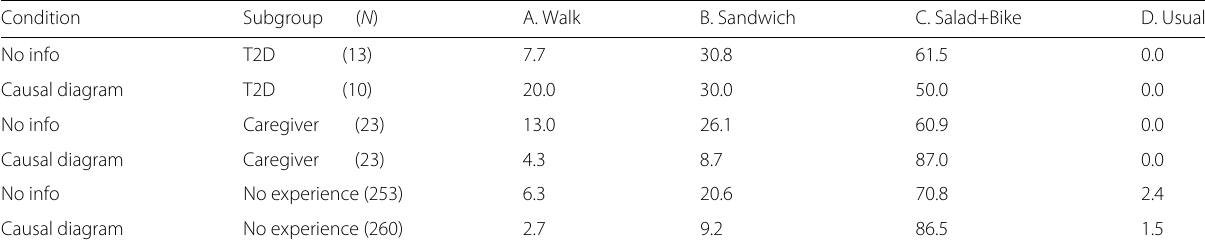
Table 2 Percentage of respondents choosing each answer in Experiment 2, broken down by level of diabetes experience Condition Subgroup ( N ) A. Walk B. Sandwich C. Salad+Bike No info Causal diagram Causal diagram Caregiver (23) No info No experience (253) Causal diagram No experience (260) Answer C is correct. N is the number of individuals in the